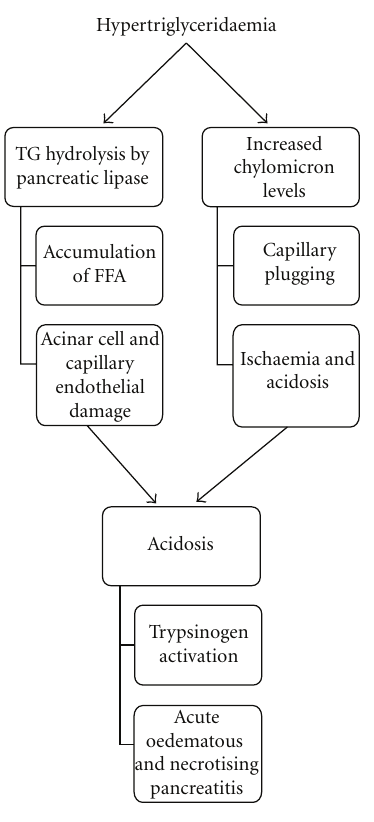
Figure 3: Pathophysiology of acute pancreatitis secondary to